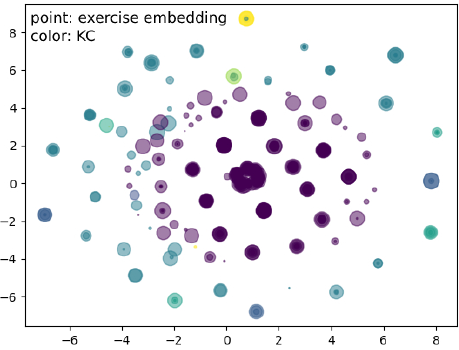
Figure 7. t-SNE visualizations of exercise embeddings.